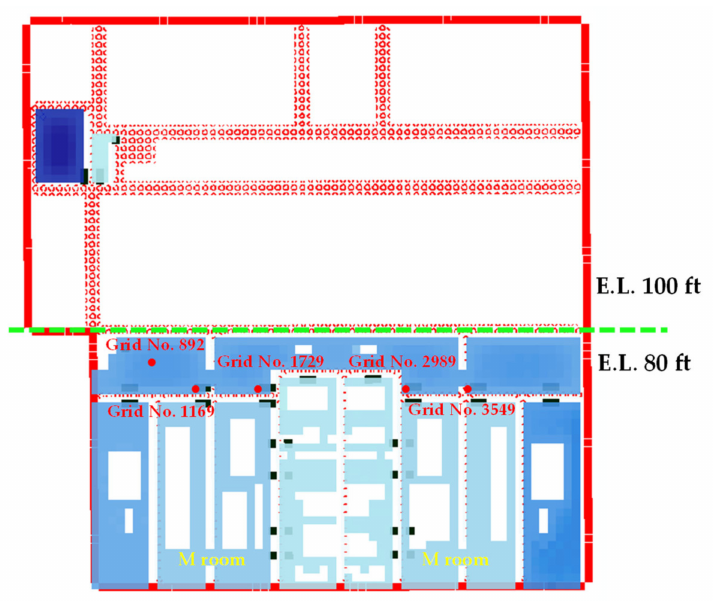
Figure 16. Flood depth points for the control building at 80 ft elevation (NPPs 3 and 4). Table 9. Maximum flood depths for probabilistic analysis in the control building of NPP 3 (elevation 80